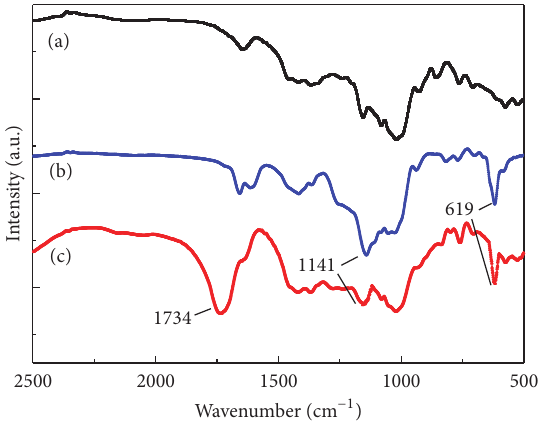
Figure 1: IR spectra of MD (a), SMD (b), and BMMD (c).